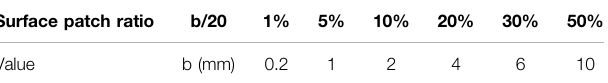
TABLE 3 | Values of the surface patch